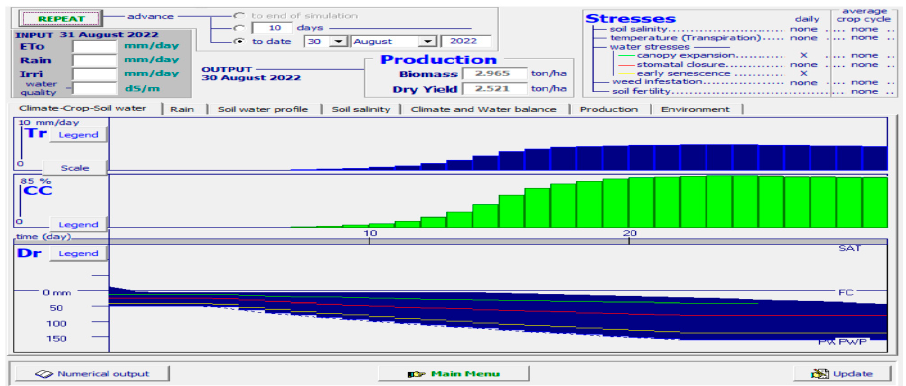
Figure 13. AquaCrop simulator results when fed with the conditions of romaine lettuce cultivated in hydroponics.